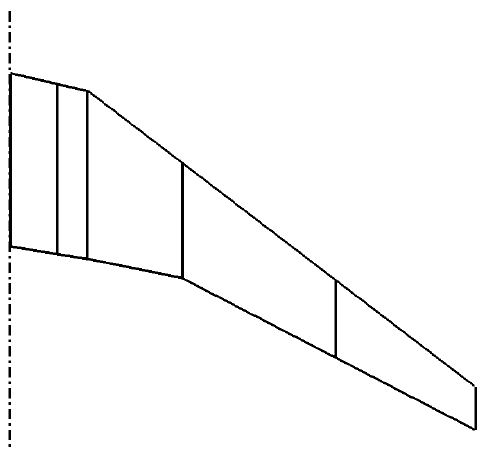
Figure 23. CRM-NLF geometry used by the aerodynamic module.